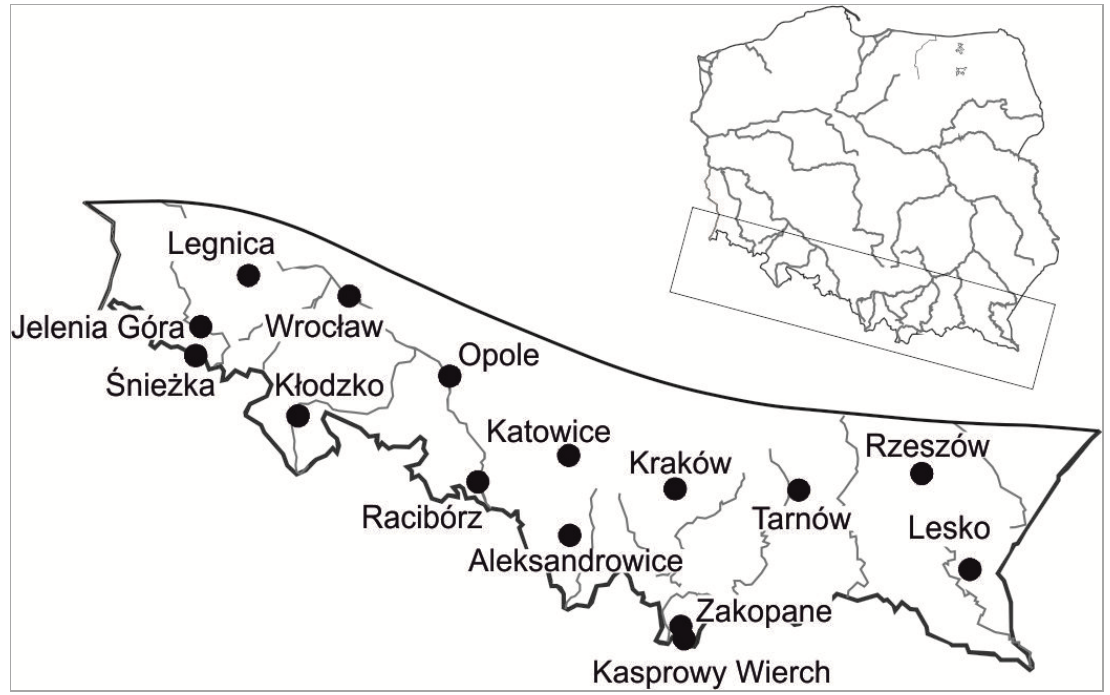
Fig. 1. Meteorological stations used in the